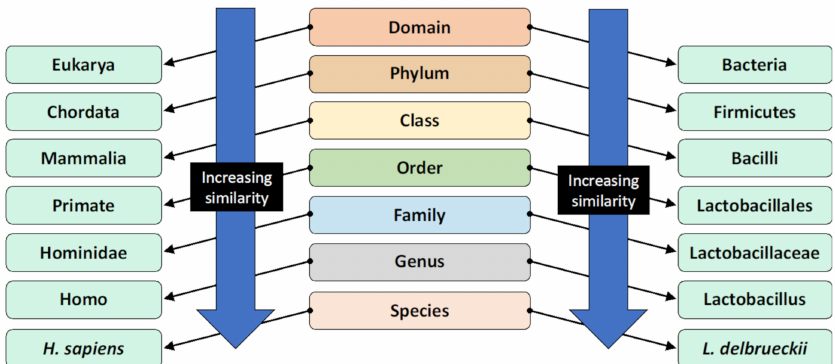
Figure 1. The taxonomic classification system and the classification of humans and Lactobacillus delbrueckii as an example [8]. Organisms are classified by this hierarchical system, where the most general and inclusive group is at the domain level. Organisms within the same species are most genetically